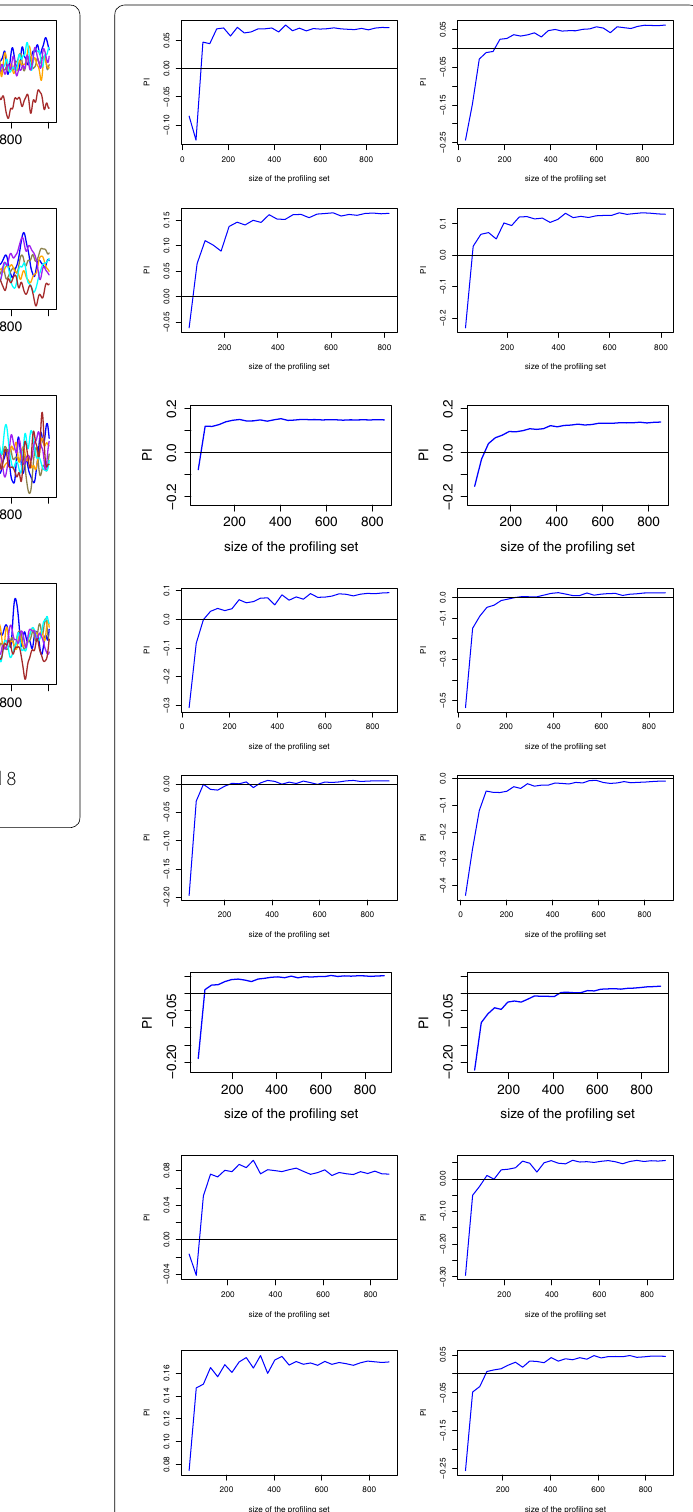
Fig. 17 Evolution of the PI in function of the size of the profiling set for Users 1 (top) to User 8 (bottom), using average PCA (left) and raw PCA